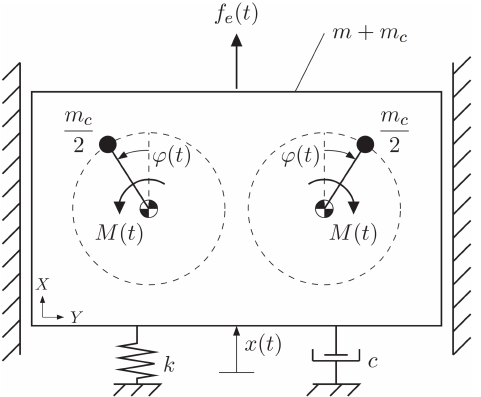
Figure 2. TRD on a single degree of freedom (SDOF) oscillator